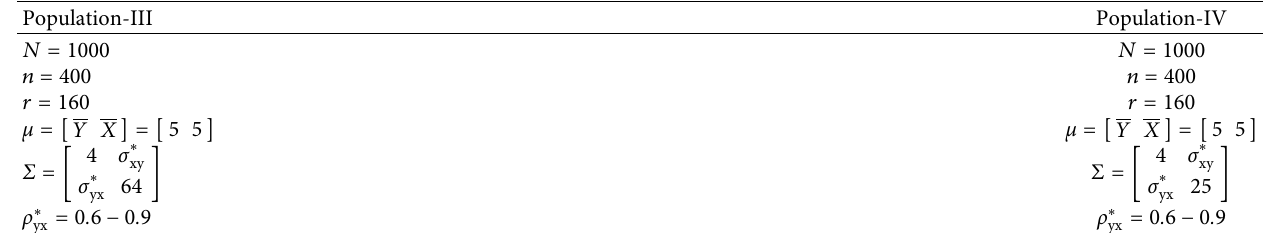
Table 6: PRE of the existing and proposed class of estimators of Population-III at ρ ∗ Strategy